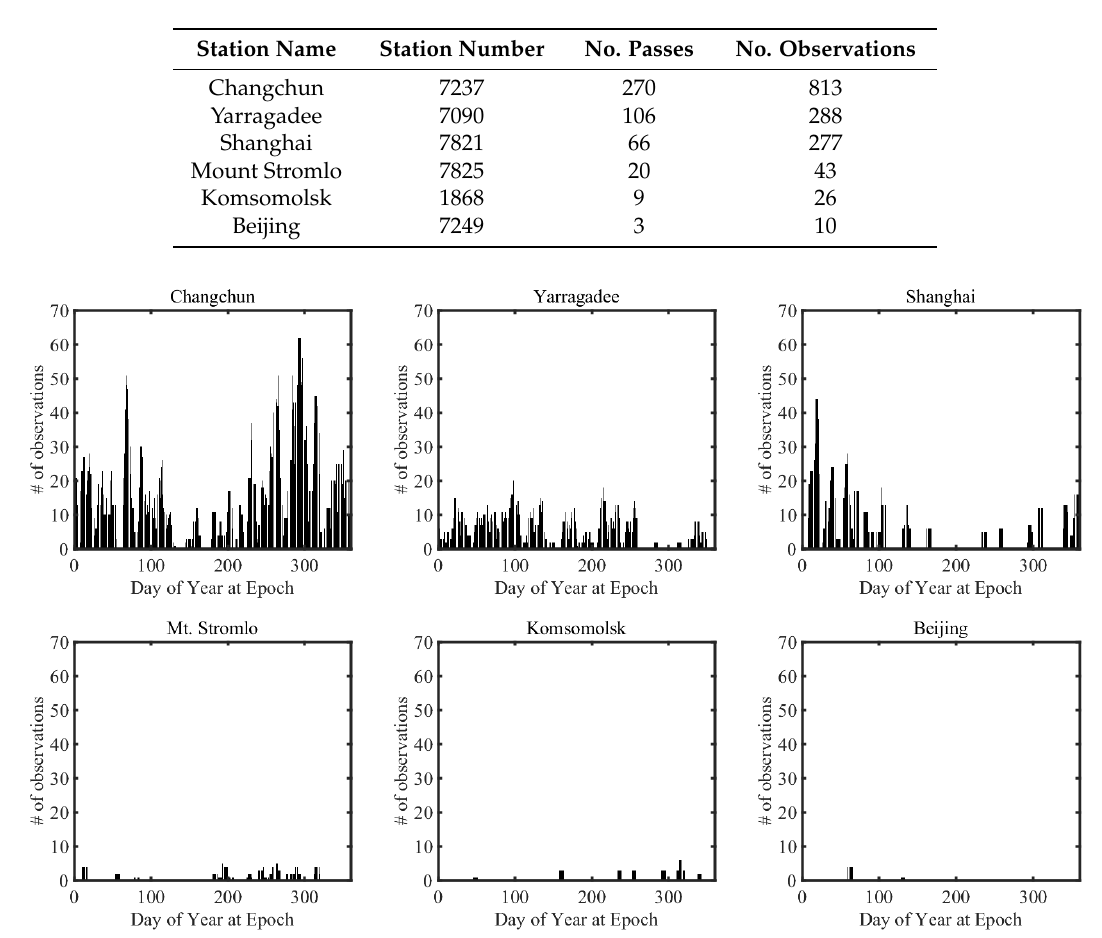
Table 3. SLR tracking statistics of Compass-G1 in 2017.